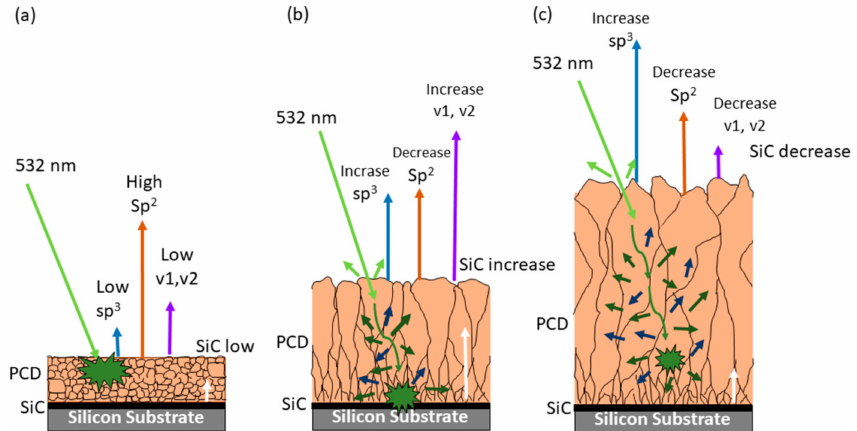
Figure 7. Schematic showing 532 nm wavelength laser beam interaction with ( a ) UNCD, ( b ) NCD, and ( c ) MCD films grown on Si substrates. For UNCD films the laser light is mostly absorbed by C atoms, with sp 2 bonds making this signal the highest contribution. As the grain size increases and the film becomes more transparent to the visible laser, the H atoms settle in the grain boundary, increasing the v1 and v2 signals. For large grain sizes, there are fewer available sites for the H to settle, and v1, v2, and sp 2 decrease, making the sp3 the dominant